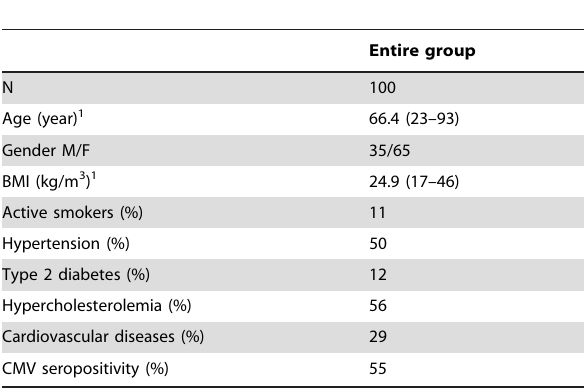
Table 1. Characteristics of the study group.